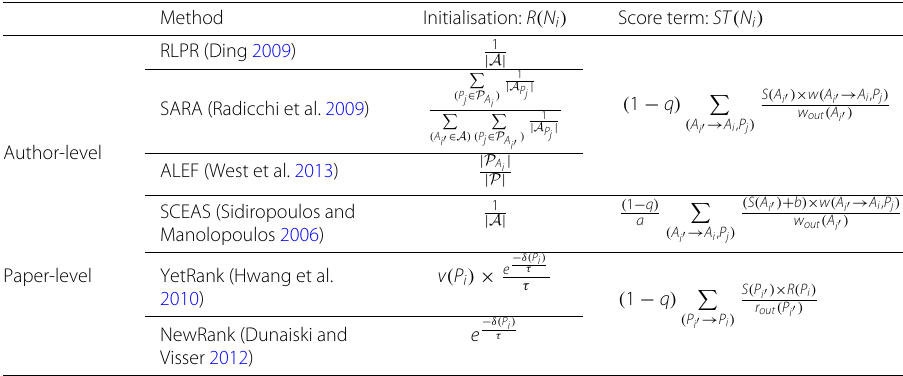
Table 1 Comparison of state of the art methods